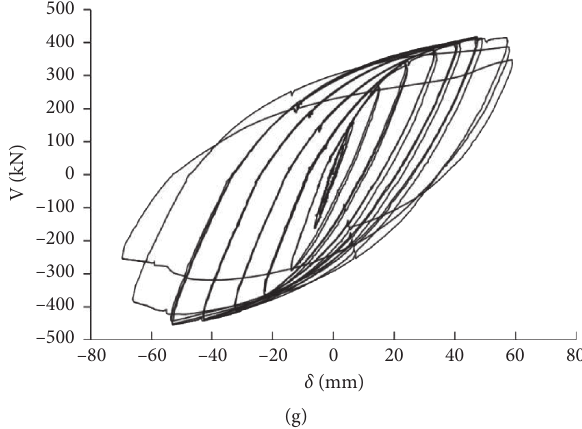
Figure 8: Load-displacement hysteresis curves of the specimens. (a) Specimen I-1 ( n � 0.20, e � 0mm). (b) Specimen II-1 ( n � 0.20, e � 0mm). (c) Specimen II-2 ( n � 0.15, e � 0mm). (d) Specimen II-3 ( n � 0.10, e � 0mm). (e) Specimen III-1 ( n � 0.20, e � 80mm). (f) Specimen III-2 ( n � 0.15, e � 80mm). (g) Specimen III-3 ( n � 0.10, e �